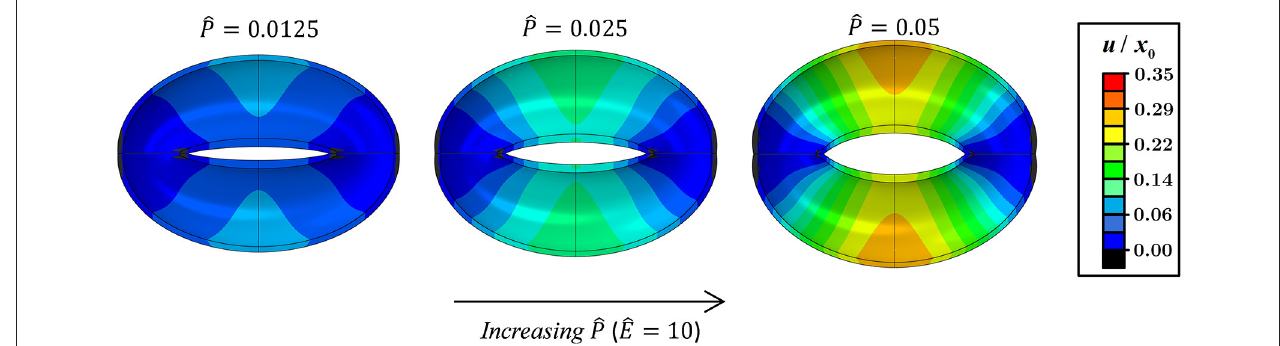
FIGURE 3 | Displacement maps of stomatal opening normalized according to x 0 for increasing ˆ P -values with ˆ E